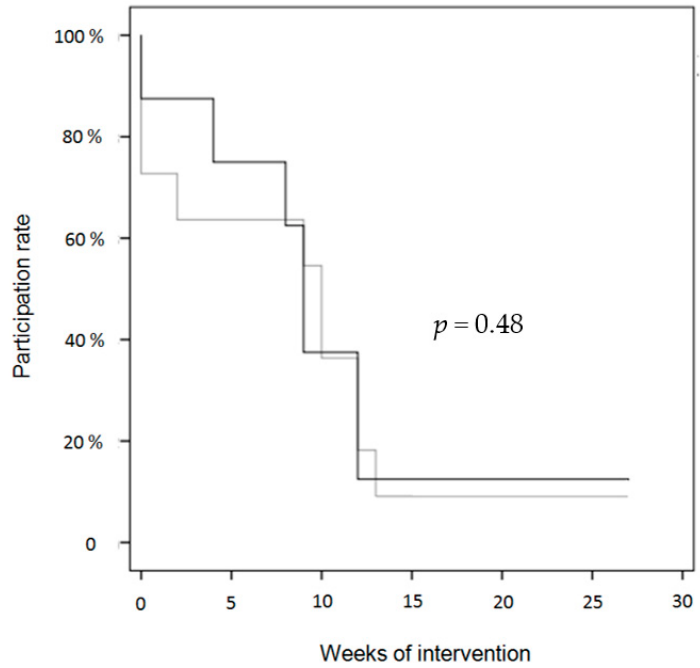
Figure 2. Kaplan-Meier survival analysis of drop-out over the time course of the intervention beginning in May at zero weeks. Grey line = control group; black line = intervention group.